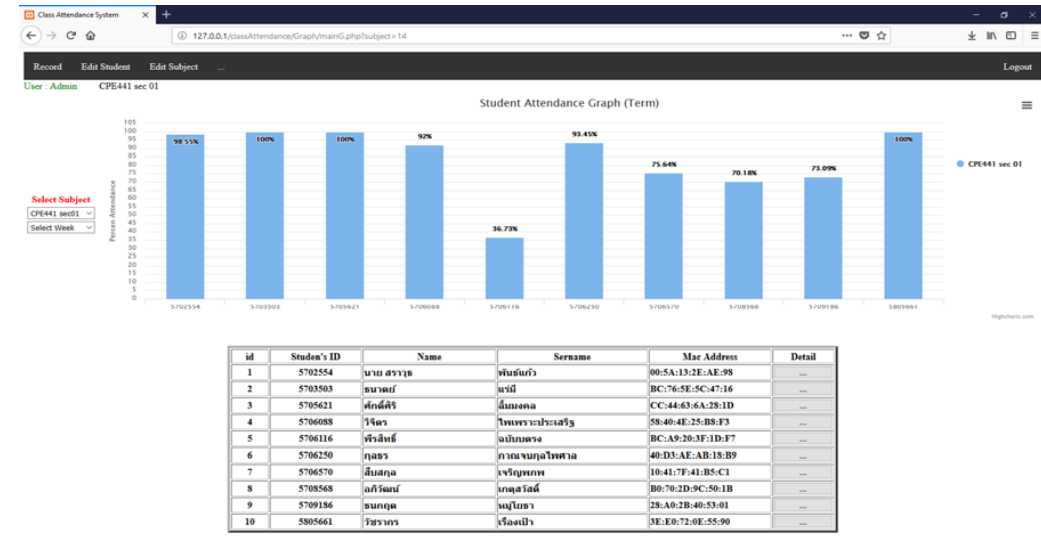
Figure 12. Summary of class attendance by semester.